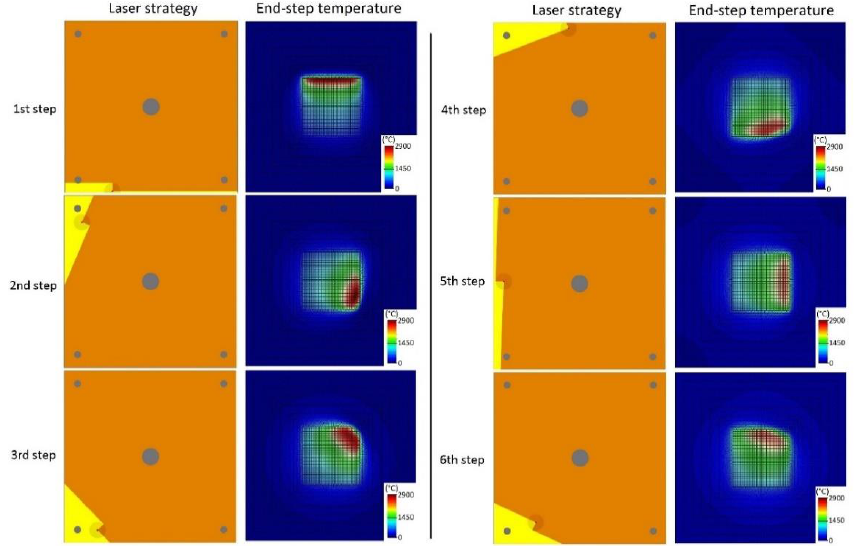
Figure 7. Scanning sequence and computed temperature contours of the substrate surface at the end of each layer step of the SLMed NIST part in Inconel 718 alloy.